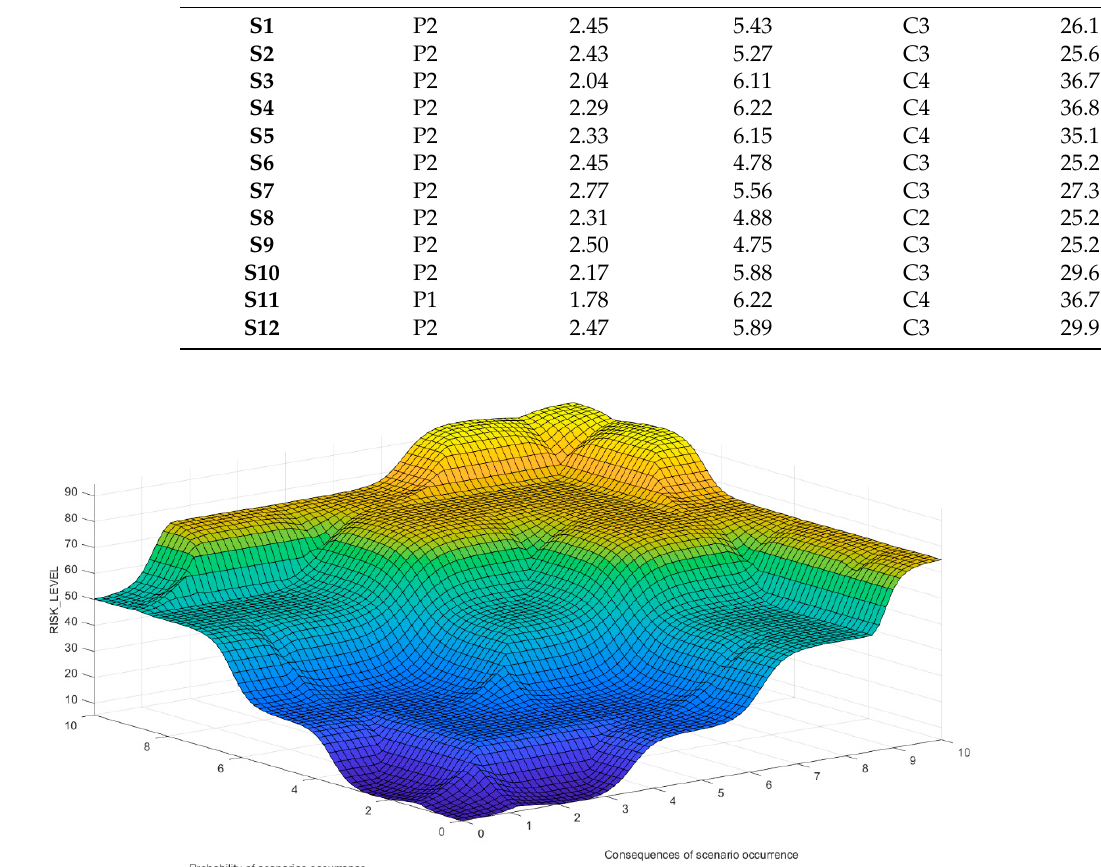
Figure 11. Risk surface generated in MATLAB.